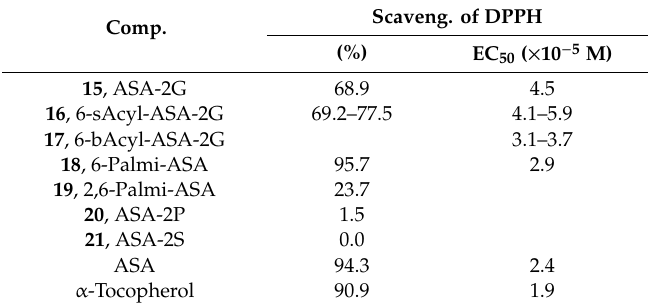
Table 4. The radical scavenging activity of glucoside ASA derivatives.